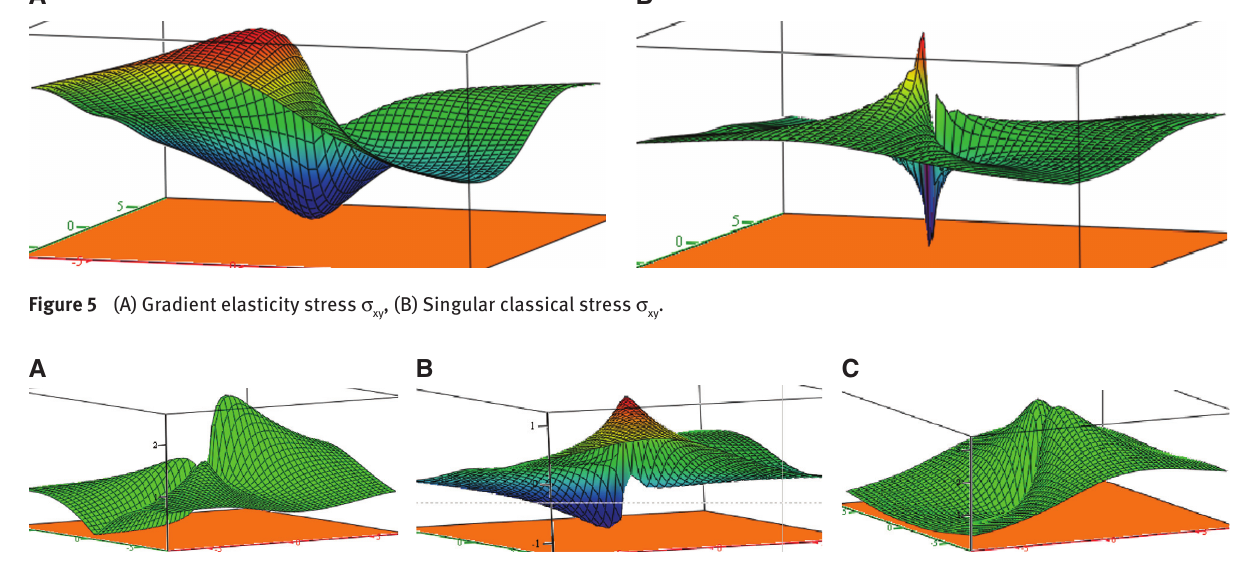
σ and σ , xx, xy yy